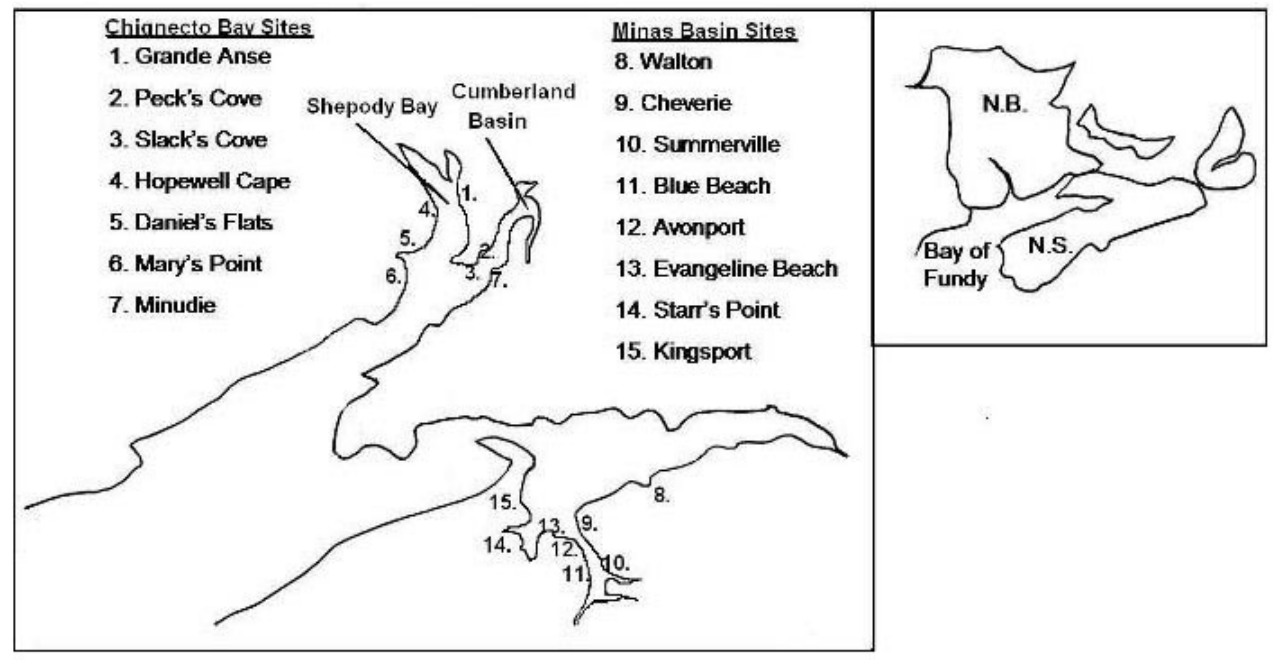
Fig. 1. Map of the Bay of Fundy, showing study sites in Chignecto Bay and Minas